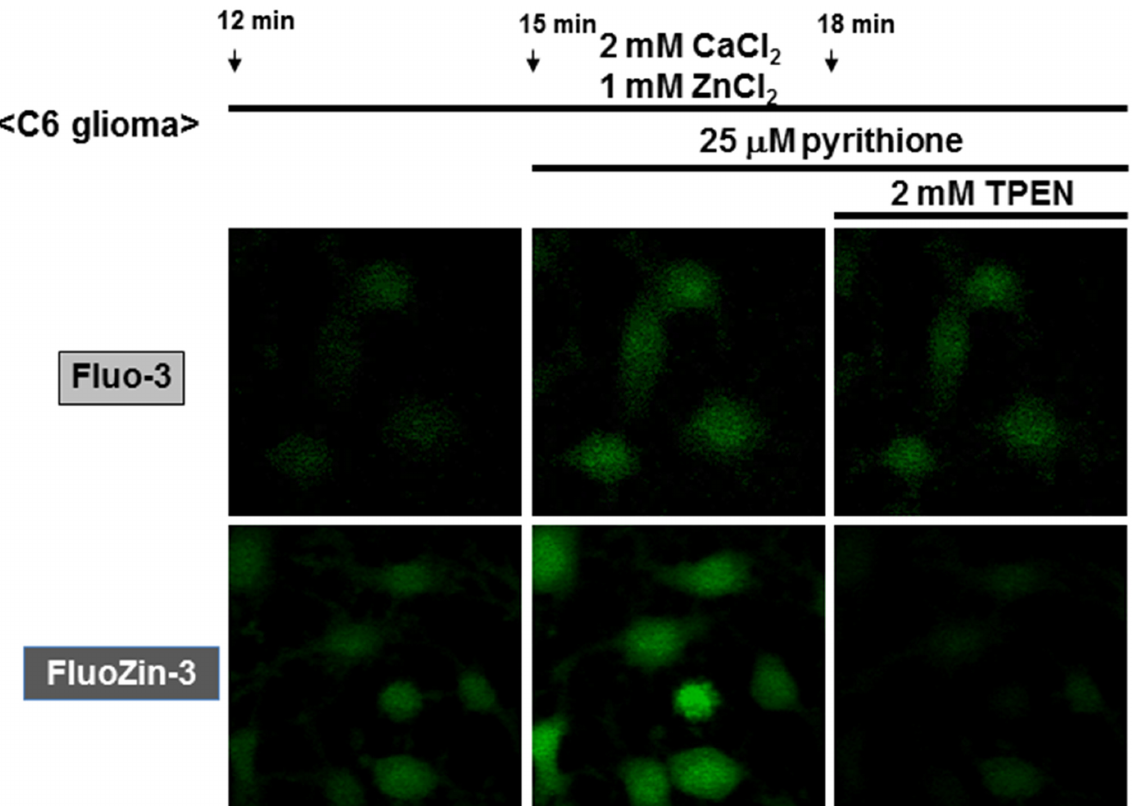
Fig 7. Micrographic pictures of both Fluo-3 and FluoZin-3 fluorescence in C6 glioma cells exposed to CaCl 2 and ZnCl 2 in the presence of pyrithione and TPEN. Typical pictures are shown here.